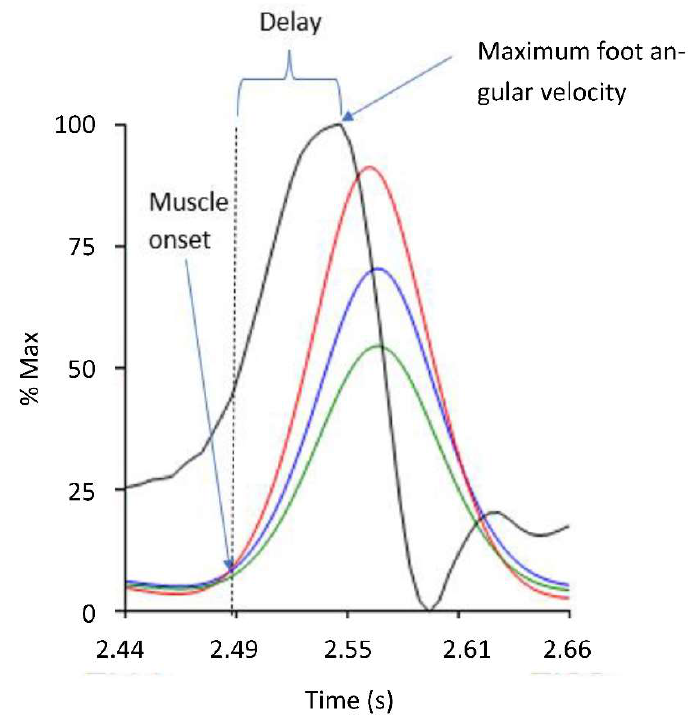
Figure 3. The delay ( ∆ t) from the muscle activation onset (i.e., AOR) and the maximum foot angular velocity. The vertical axis represents the percentage of maximum angular velocity (black) and linear envelope of the Gastrocnemius Medius (red), Gastrocnemius Lateralis (blue), and Soleus (green) muscles activations during the MTS V3 test, normalised to their peak value (% of max).